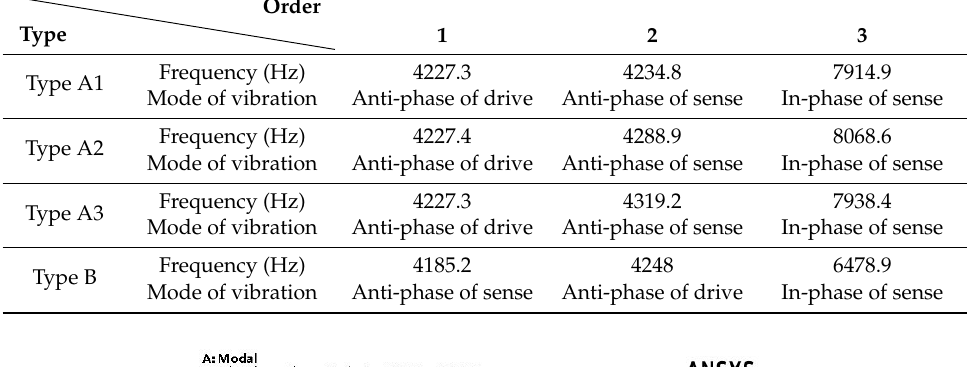
Table 3. Natural frequencies of first three modes and corresponding modes of vibration of all types.